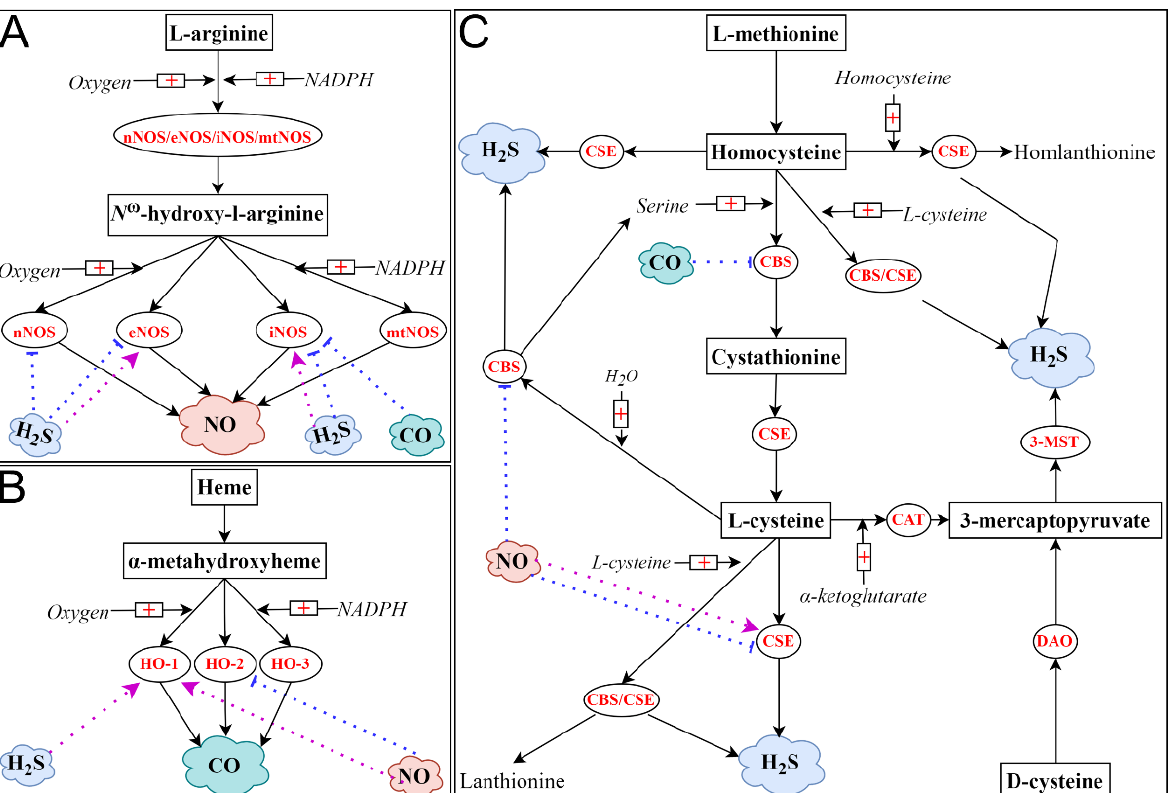
Figure 2. Enzyme-derived endogenous production of NO ( A ), CO ( B ) and H 2 S ( C ). Endogenous NO is produced from a two-step biological process catalyzed by NOS. L-arginine is hydroxylated to N ω -hydroxy-l-arginine; the latter is further oxidized to L-citrulline and NO. Endogenous CO is generated from the degradation of heme. Firstly, heme is oxidized to α -metahydroxyheme in the presence of oxygen and NADPH. Secondly, α -metahydroxyheme reacts with oxygen, resulting in the biosynthesis of CO. NADHP is also required for this reaction. Relatively, the biosynthesis of H 2 S is more complex as H 2 S can be generated from four enzymatic pathways. Briefly, H 2 S is naturally produced from the desulfydration of L-cysteine or homocysteine catalyzed by CBS, CSE and 3-MST/CAT. Specifically, CBS and CSE are involved in transsulfuration reactions, whereas 3-MST is responsible for L-cysteine catabolism. Recently, the 3-MST/DAO pathway has gained acceptance as the fourth pathway for H 2 S biosynthesis, using D-cysteine as the substrate. The biosynthesis of every gaseous mediator might be affected by the remaining two gases. Purple arrow: activation; blue arrow: